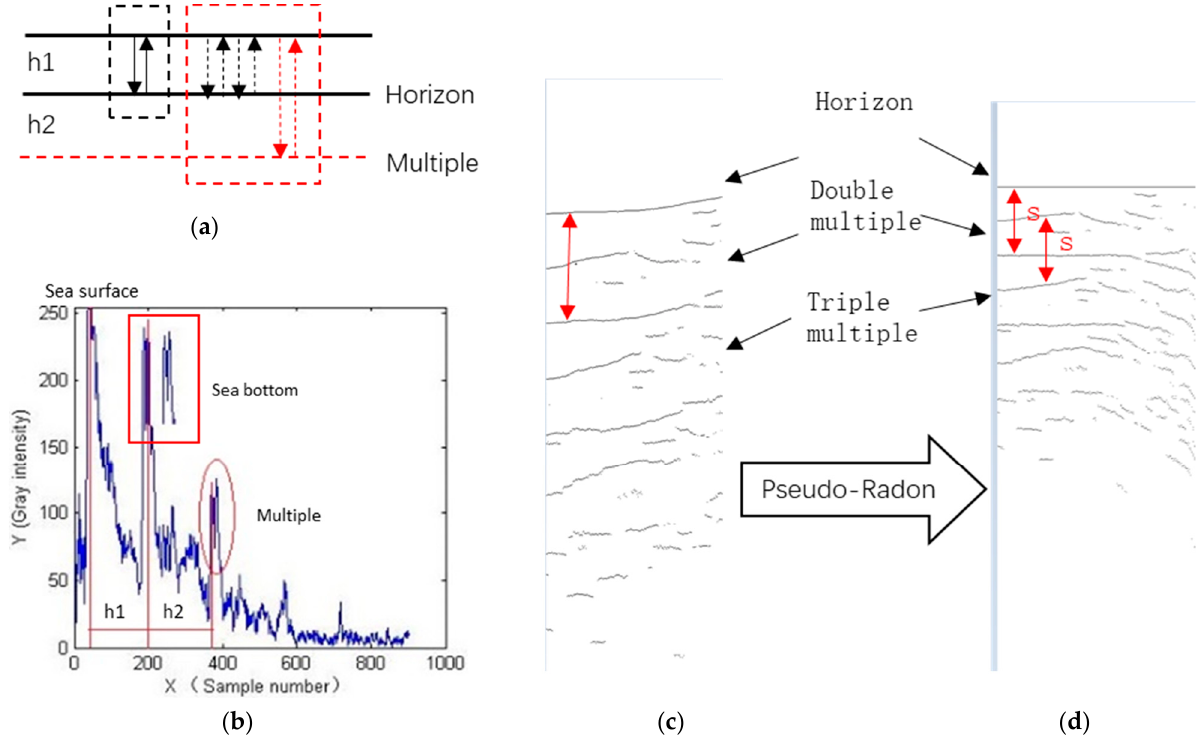
Figure 8. Pseudo-Radon transform. ( a ) The formation mechanism of horizons and multiples. The propagation path of the signal in the black dotted rectangle depicts the formation of the horizon. The propagation path in the red dotted rectangle depicts the formation of the multiples. In the red dotted rectangle, the red path is the equivalent form of the black path. According to the formation mechanism of the multiples, h1 = h2. ( b ) The reflection sequence of one ping. The rectangle is the sea bottom, and the ellipse is the double surface-related multiples. The signal shapes in the rectangle and the ellipse are similar. ( c ) A prediction result of the DL method. It is a binary image containing the multiples and horizons. ( d ) A transformed image. The horizon, double multiples, and triple multiples are approximately parallel. The spacing between adjacent lines is close to s, the scaling parameter in pseudo-Radon transform.